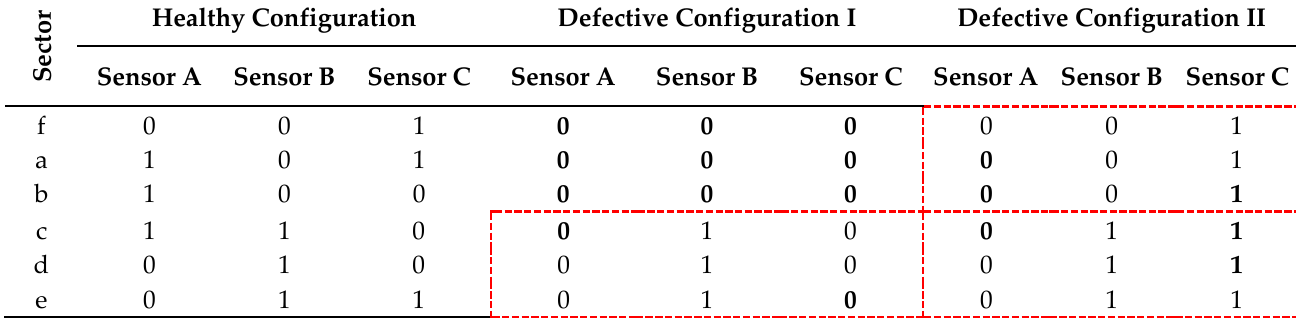
Table 5. The healthy commutation sequence compared to a double breakdown fault of position sensor A at high state and sensor C at different